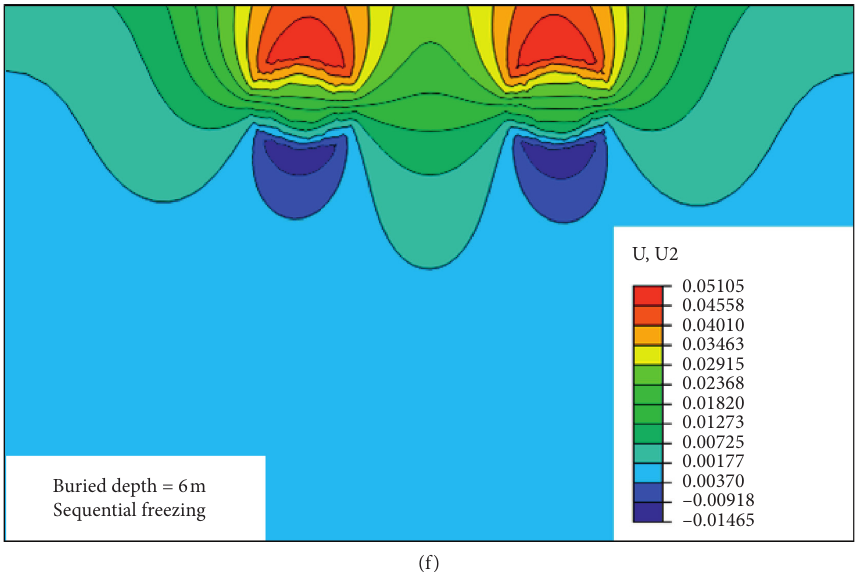
Figure 9: Vertical displacement field of the ground (unit: m). (a) 0.25 D, (b) 1.00 D, (c) 1.50 D, (d) 2.00 D, (e) 2.50 D, and (f) 3.00